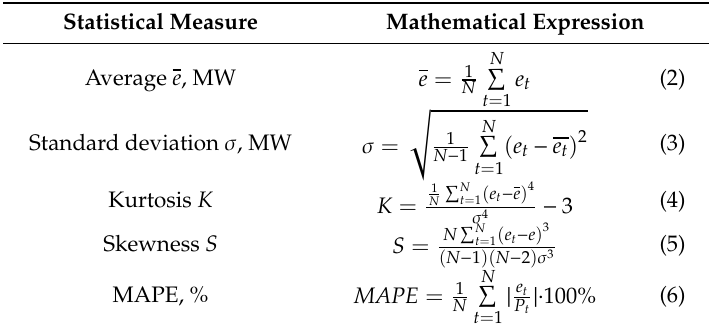
Table 2. Statistical measures for wind power forecast